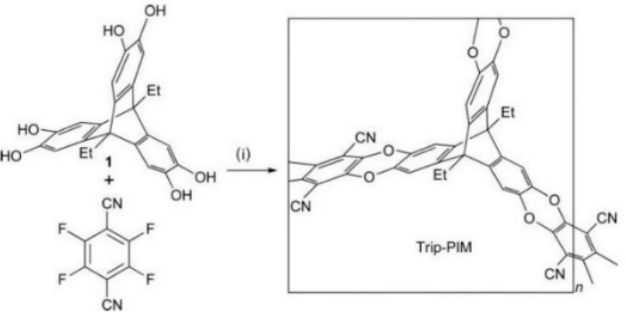
Figure 9. Synthesis of the triptycene-based PIM (Trip-PIM). Reagents and conditions: (i) K 2 CO 3 , DMF, 80 °C. Reproduced from Reference [70].